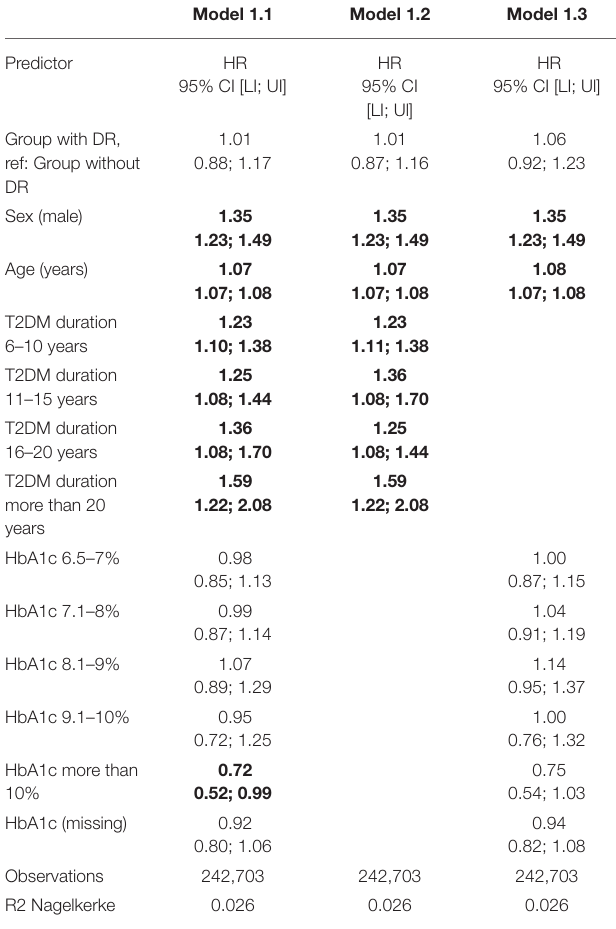
TABLE 5 | Additional models for adjusted hazard ratios for different